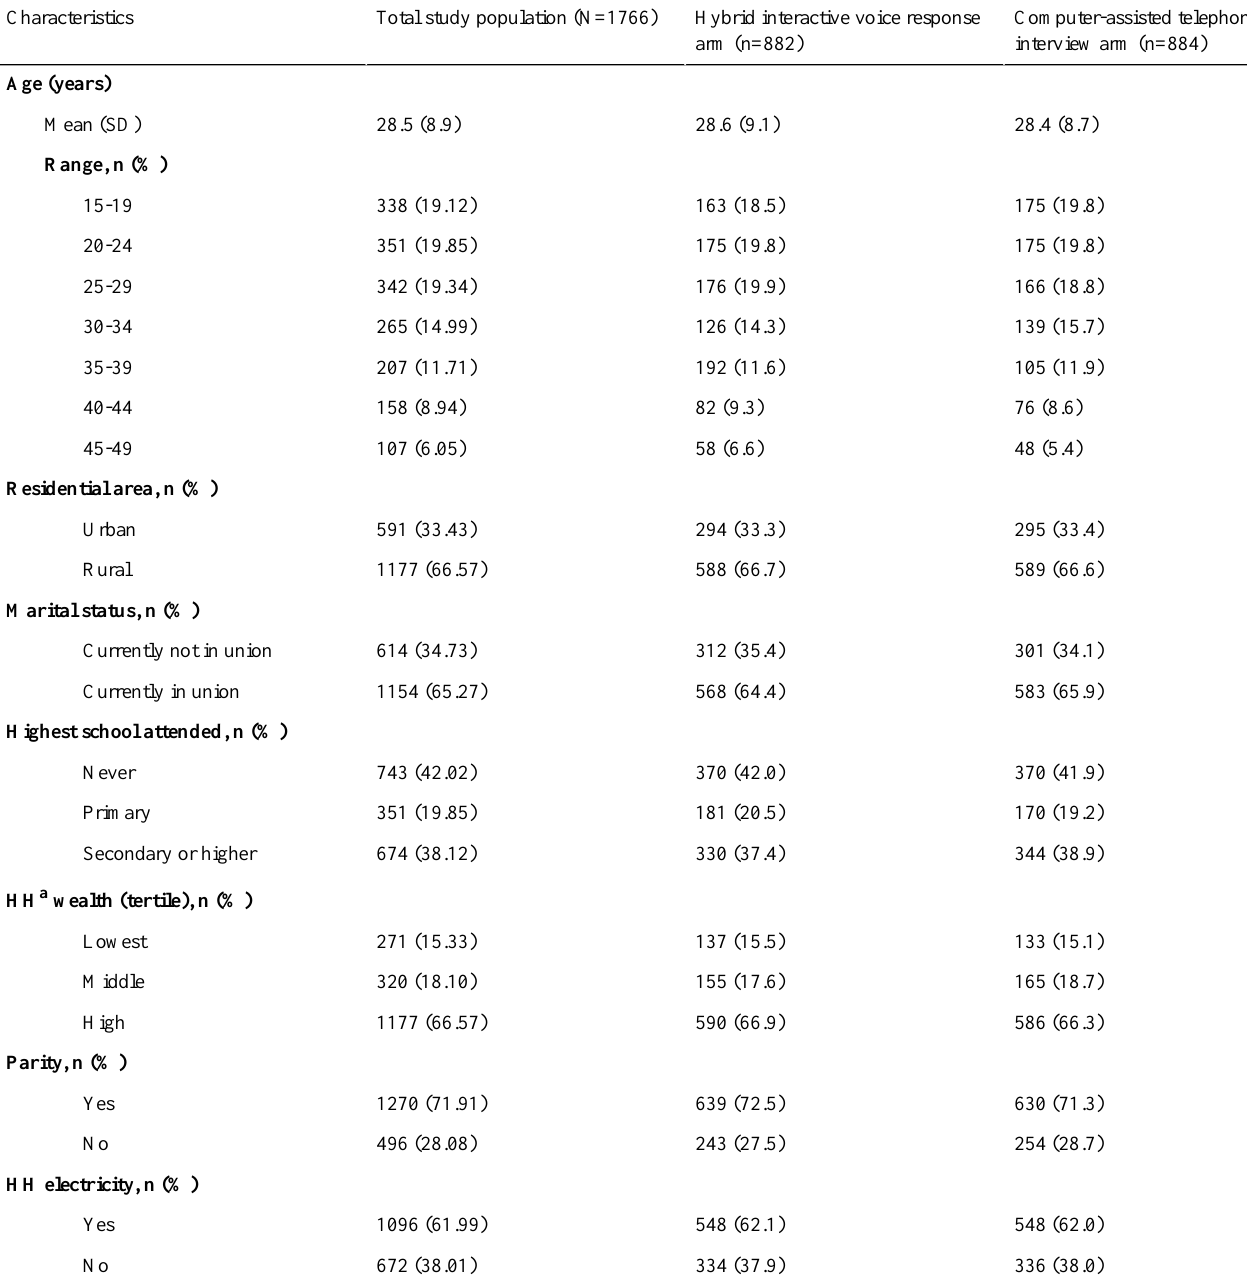
Table 2. Sample characteristics of female cell phone owners in Burkina Faso, overall and by study arm.